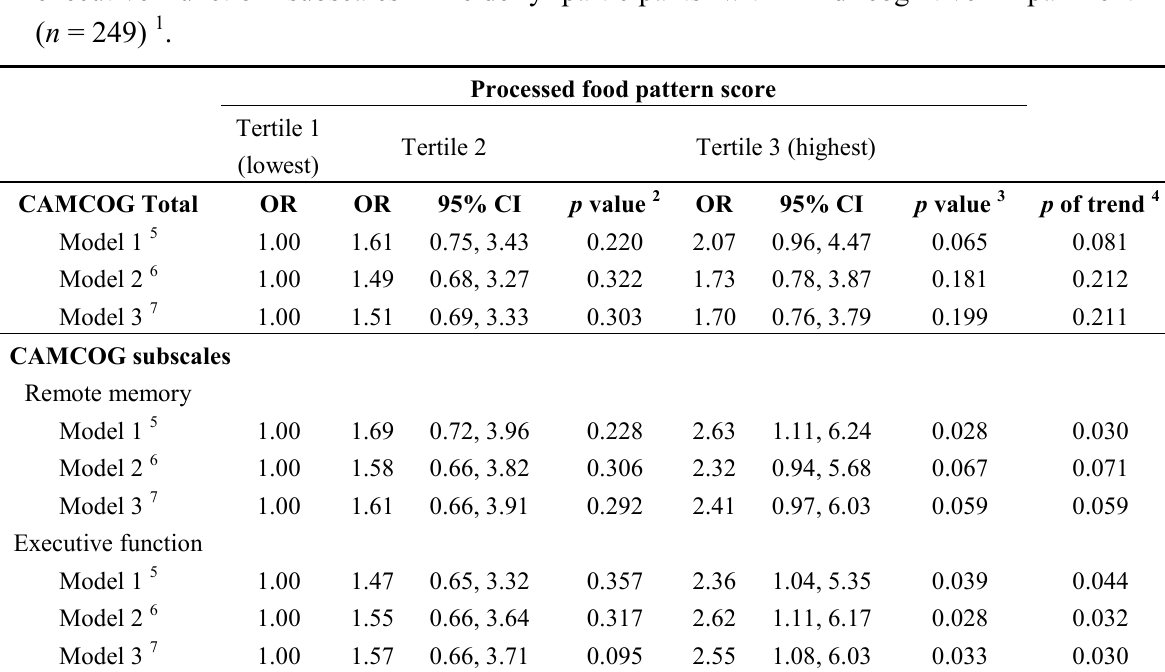
Table 3. Association between tertiles of processed food patterns on dietary questionnaires and the lowest tertile of cognitive functioning as assessed by CAMCOG and memory and executive function subscales in elderly participants with mild cognitive impairment ( n = 249) 1